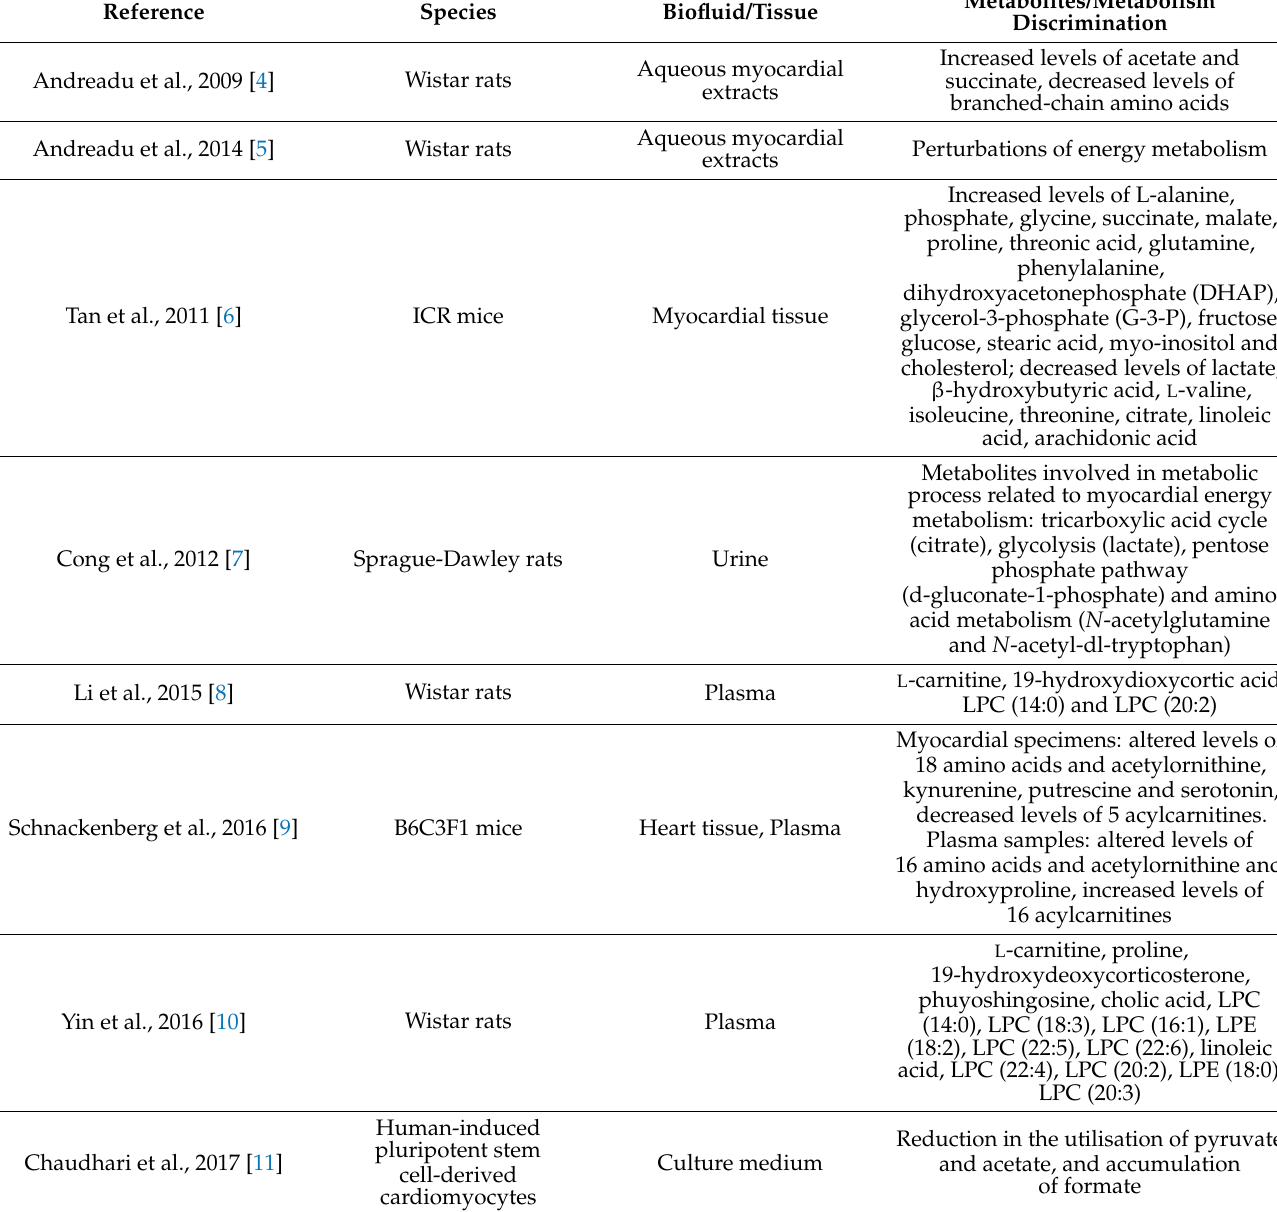
Table 1. Summary of techniques and results for early detection of drug-induced cardiotoxicity in animal